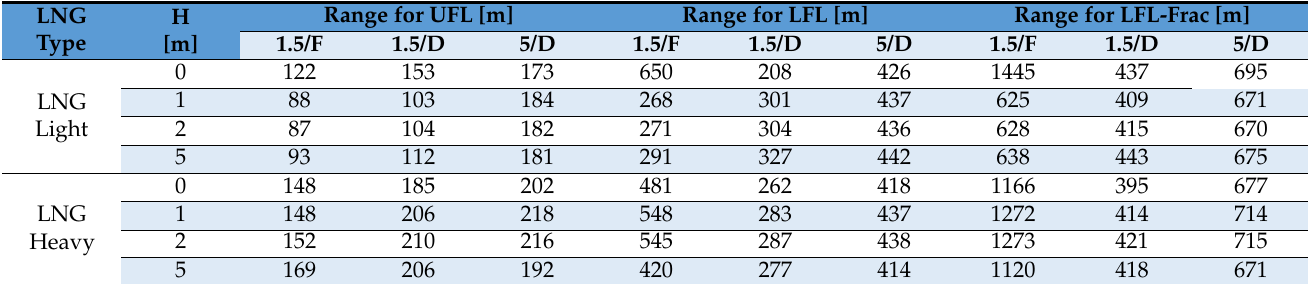
Table 3. Dispersion, catastrophic rupture, winter.